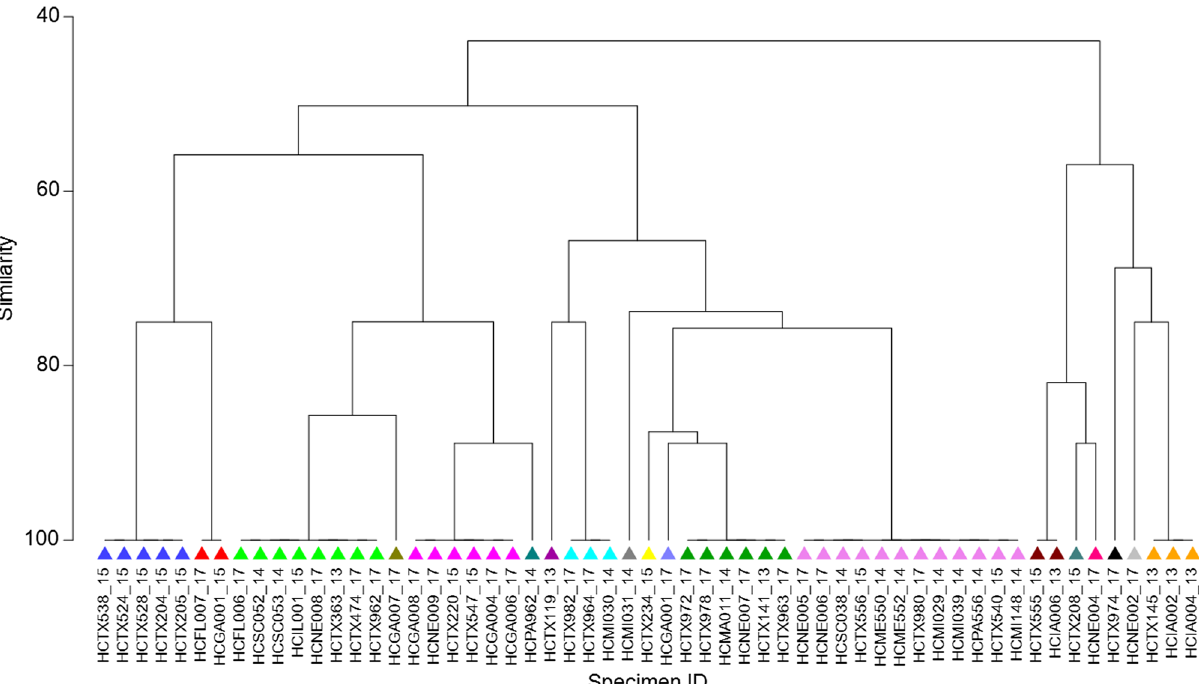
Figure 1. Cluster dendrogram, using Bray-Curtis values, to visualize diverse potential of the four markers described here. This fi gure demonstrates the amount of variability captured through the combination of these four markers and that they were able to resolve 57 specimens into 19 distinct